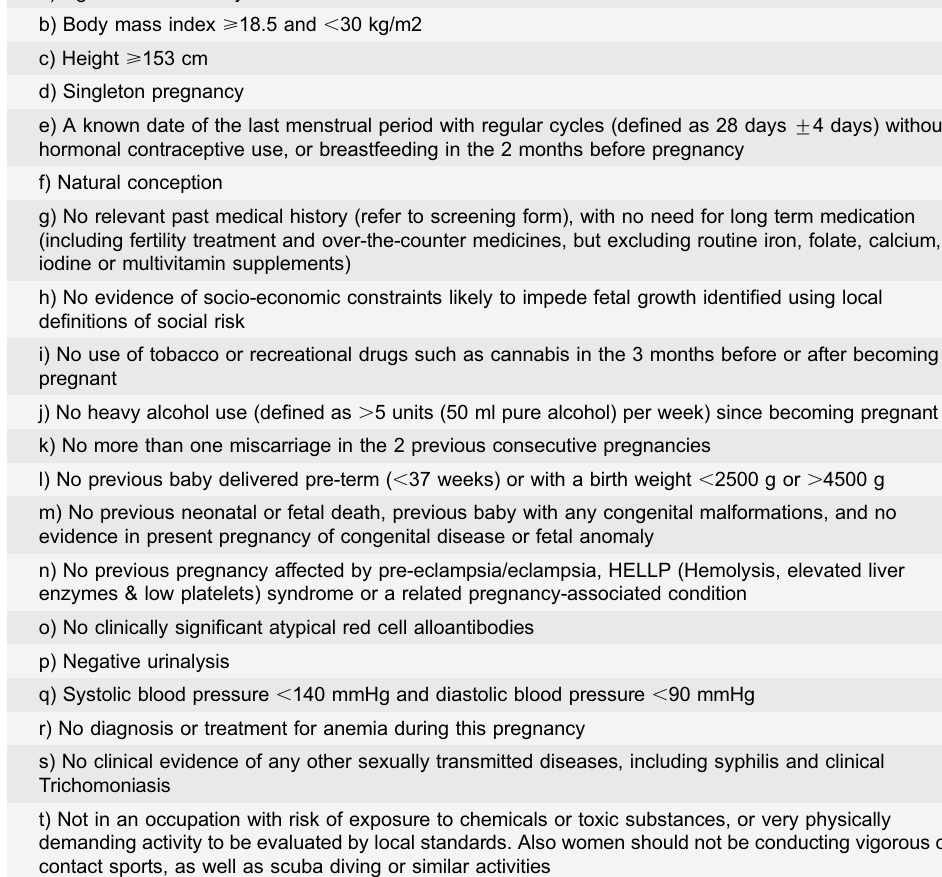
Table 2. Inclusion criteria to be met by mothers at booking for recruitment in the INTERGROWTH-21 st Project. Inclusion criteria for the INTERGROWTH-21 st Project Maternal